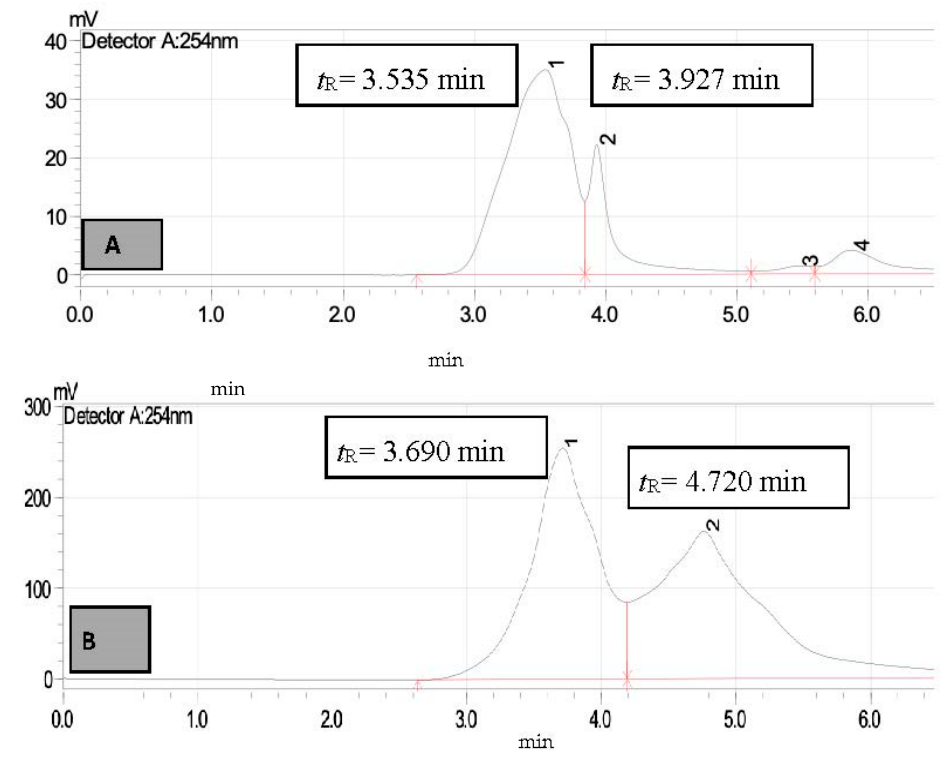
Figure 10. HPLC chromatogram of STIE ( A )—untreated sample ( B )—treated sample, peak 1 for diphenylamine ( t R = 3.690 min) and peak 2 ( t R = 4.720 min) for unknown compound.